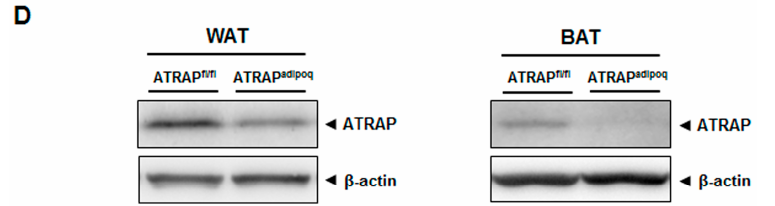
Figure 1. Generation of adipose tissue-specific angiotensin II type-1 receptor-associated protein (ATRAP) downregulated mice. ( A ) Schematic representation of Adipoq-Cre mediated recombination in adipocytes: ( a ) wild-type allele; ( b ) targeting vector; ( c ) targeted allele; ( d ) Flp recombinase-mediated allele; and ( e ) Cre -mediated allele. ( B ) Agarose-gel electrophoresis of PCR products amplified with following primer sets, ( a ) F23005 and R23744, ( b ) F24587 and R24917, and ( c ) Cre-fw and Cre-rw for Cre transgene, mAgtrapChIPF and mAgtrapChIPR for Agtrap gene as an internal control. These primer sequences are described in Table 1. ( C ) The relative ATRAP mRNA levels in each tissue (WAT, BAT, liver, muscle, kidney, heart, and brain) of ATRAP adipoq and ATRAP fl/fl mice aged 19–24 weeks on an LFD ( n = 3–10). ( D ) Representative Western blots of ATRAP protein expression in WAT and BAT of ATRAP fl/fl mice on an LFD. Values are the means ± standard error of the mean (SEM). † p < 0.05, †† p < 0.01 vs. ATRAP fl/fl mice. Data were analyzed by unpaired Student’s t -test. EX: Exon; PGK-Neo : Phosphoglycerate kinase 1 promoter driven neomycin resistant gene; PGK-TK : Phosphoglycerate kinase 1 promoter driven SV40 thymidine kinase gene; WAT: White adipose tissue; BAT: Brown adipose tissue; LFD: Low-fat diet.